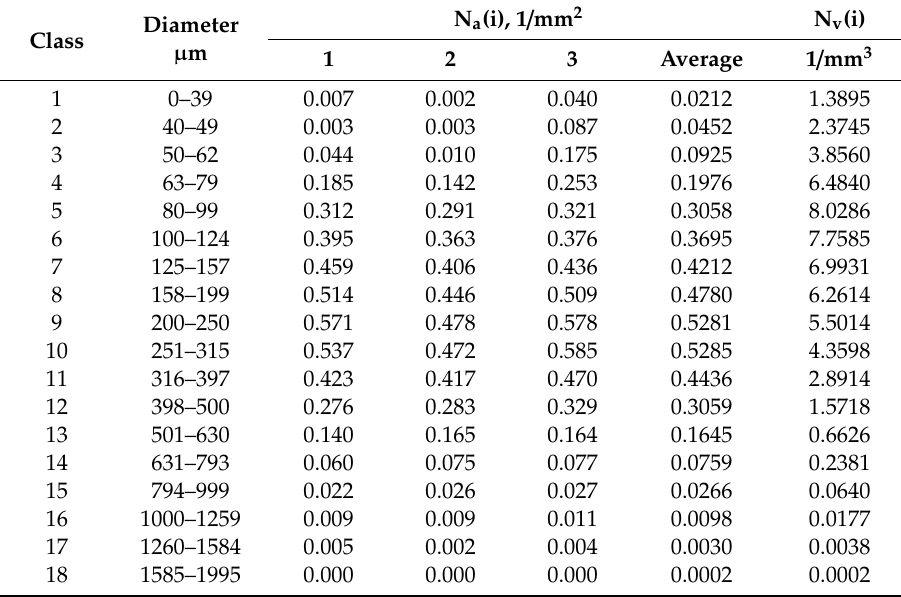
Table 1. Number of particles N a (i) per 1 mm 2 of the specimen area and the corresponding calculated number of particles N v (i) per 1 mm 3 .